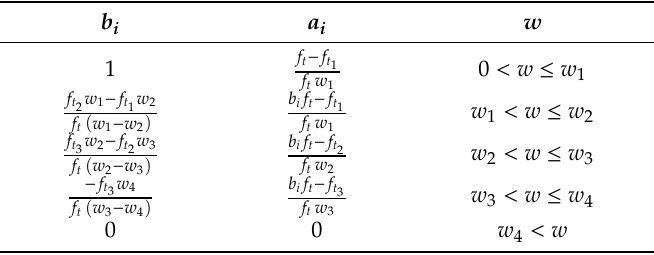
Figure 3. Quadrilinear stress–crack opening relationship.